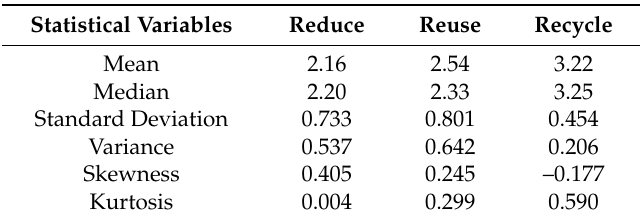
Table 4. A statistical analysis of the system input variables.